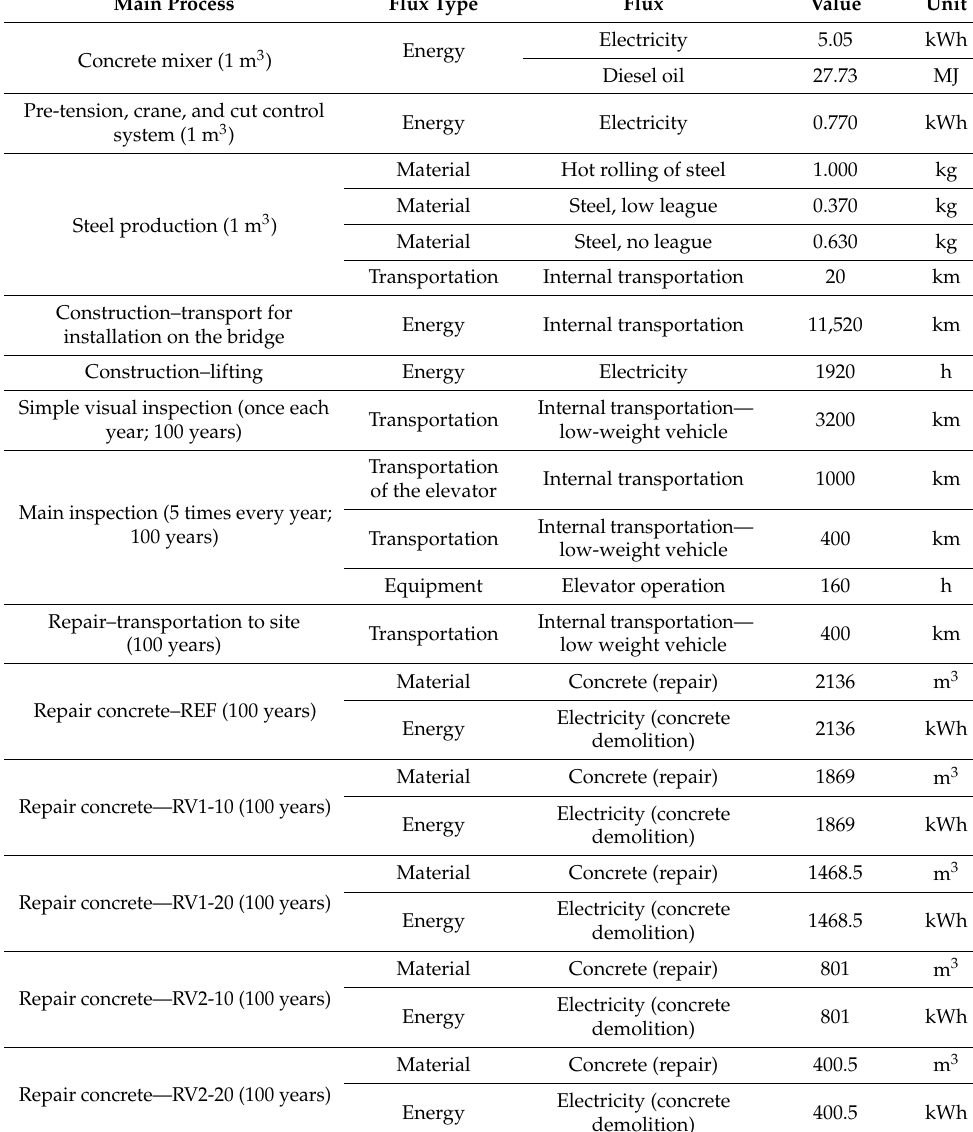
Table 7. Production, maintenance, and repair Life Cycle